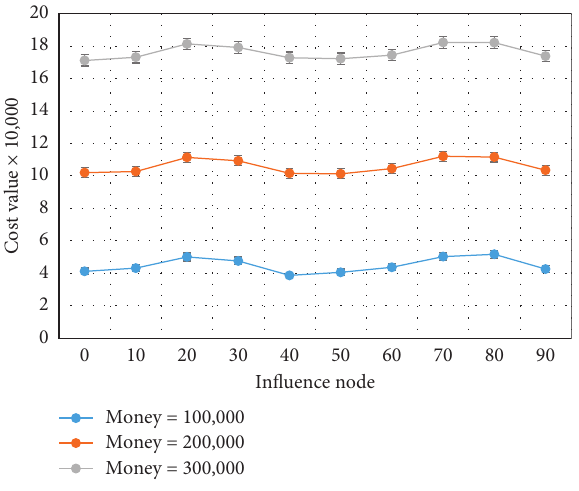
Figure 6: Diffusion budget.